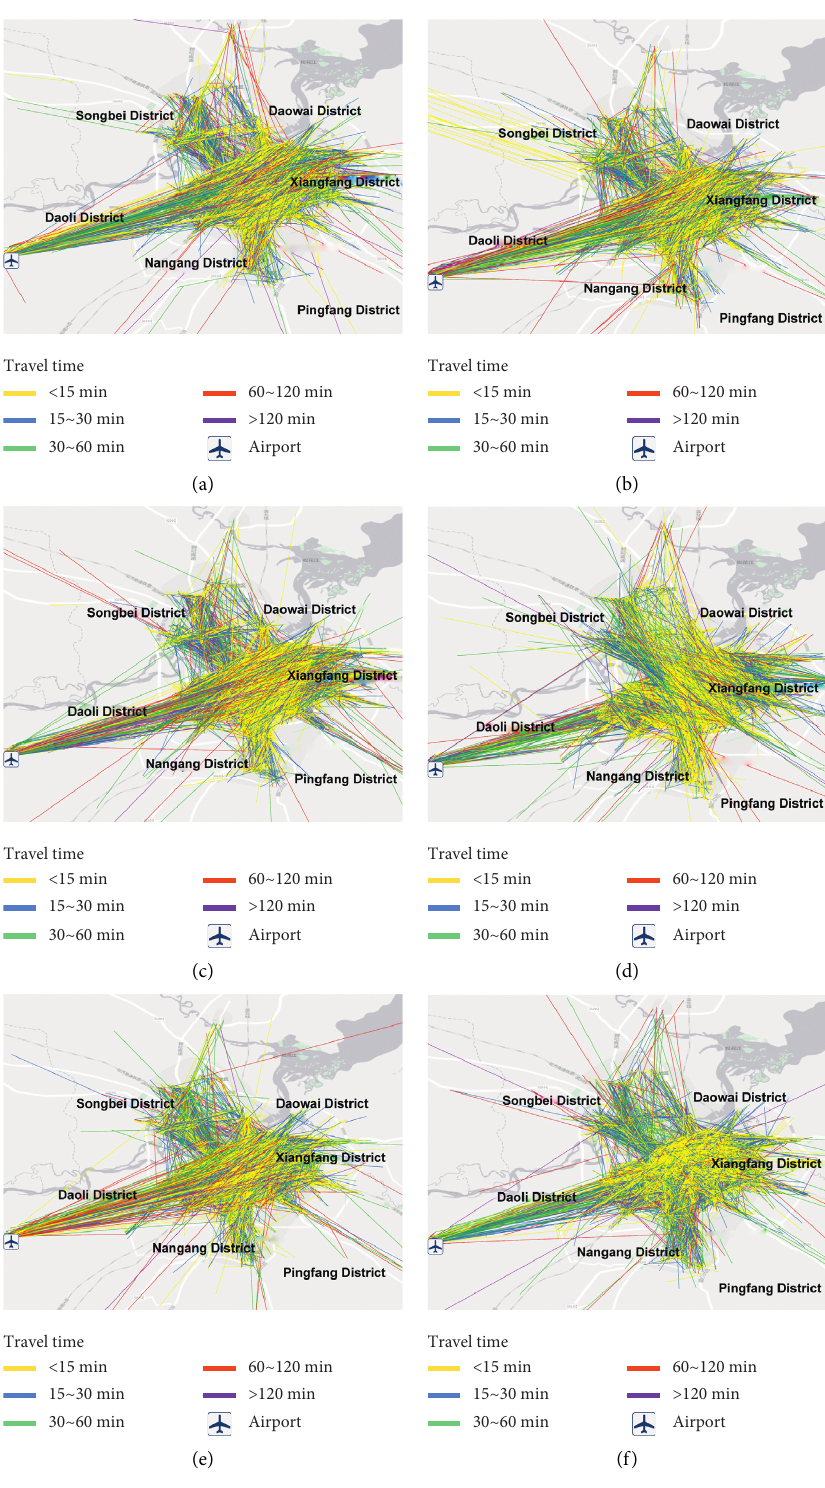
Figure 8: OD distributions with different trip duration levels during the 6 days. (a) December 9, (b) December 10, (c) December 11, (d) December 12, (e) December 13, and (f) December